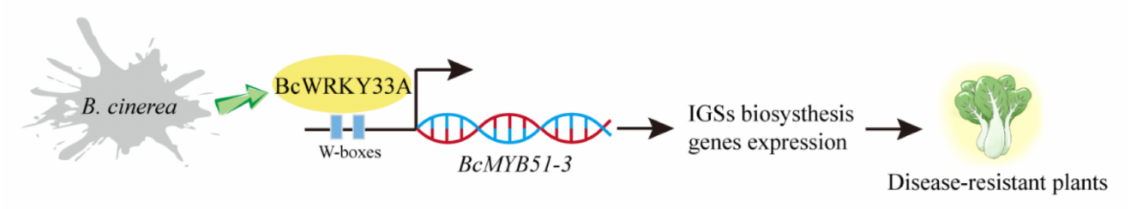
Figure 8. The working model of BcWRKY33A and BcMYB51-3 in the modulation of IGS’ biosynthesis gene expression to affect the interactions of plants and B. cinerea . The B. cinerea infection induced massive accumulation of BcWRKY33A, which directly binds to the W-boxes in the promoter of BcMYB51-3 , and the activation of the transcription of BcMYB51-3 contributed to increasing the expression of IGSs’ biosynthetic genes, thereby improving the plants’ resistance against B. cinerea